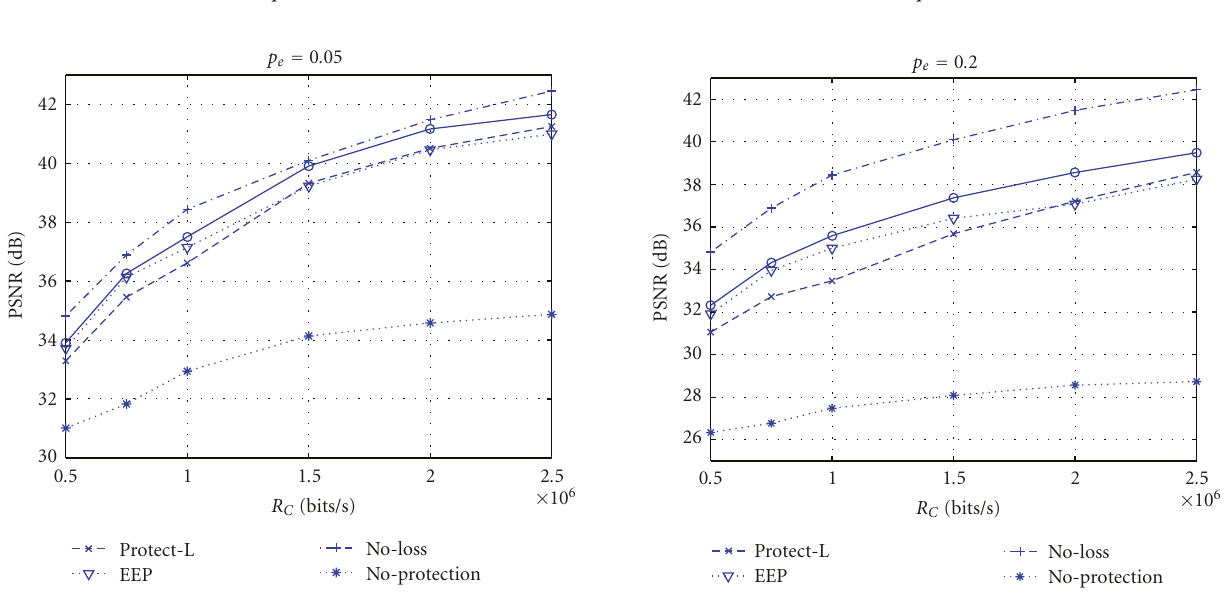
Figure 18: Results for p e = 0 . 03 for “Rena” video.